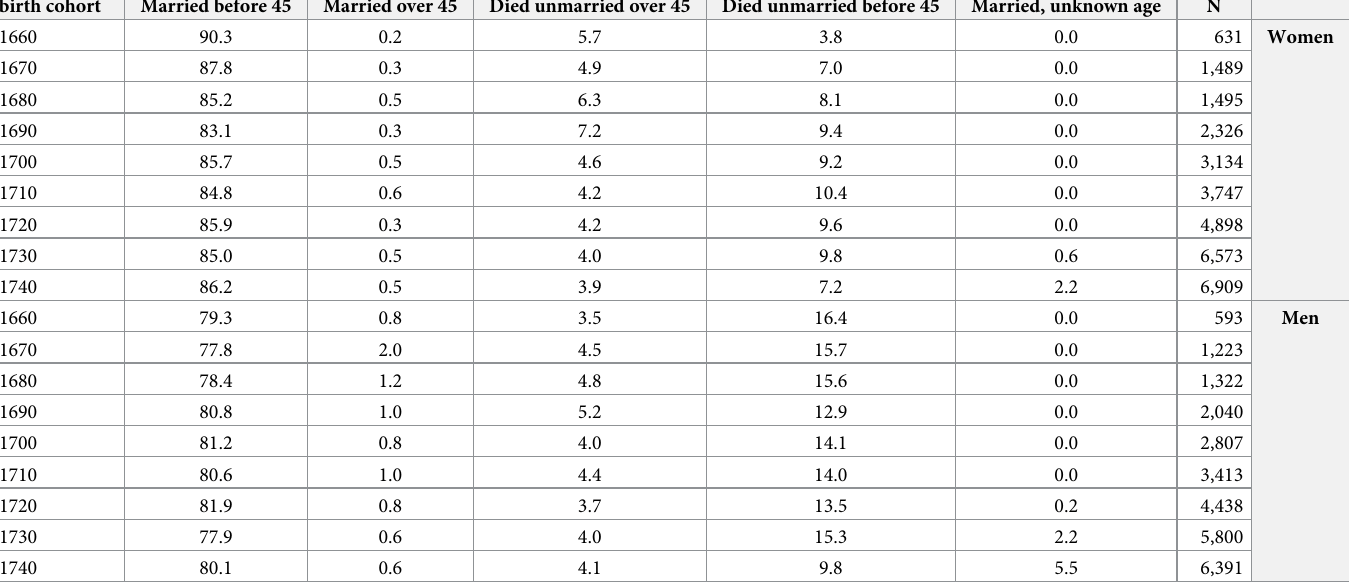
Table 2. Likelihood of marriage for individuals born in the St. Lawrence Valley parishes by birth